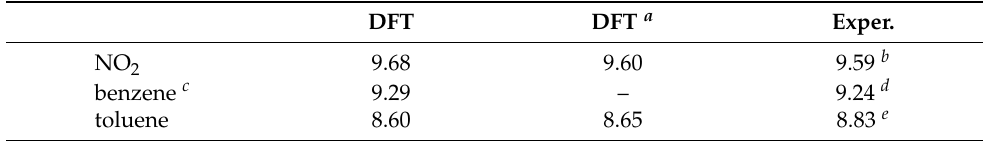
Table 1. Predicted gas phase ( ω B97XD/ma-TZVP) and experimental adiabatic ionization poten- tials